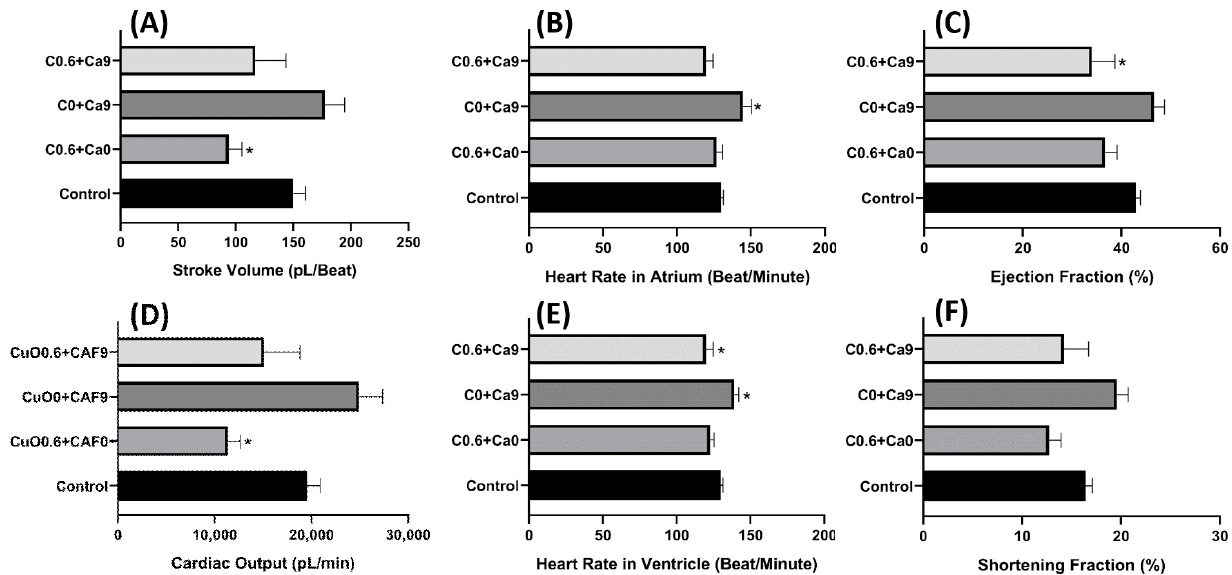
Figure 7. Cardiac physiology alteration induced by CuO nanoparticle and carbofuran co-incubation in zebrafish larvae. ( A ) Stroke volume. ( B ) Heart rate of atrium. ( C ) Ejection fraction. ( D ) Cardiac output. ( E ) Heart rate of ventricle. ( F ) Shortening fraction. Data were statistically analyzed using the ordinary one-way ANOVA test with the Dunnett post-hoc test for multiple comparison analysis. * p < 0.05. (CuO = copper nanoparticle (mM), CAF = carbofuran (µM)).